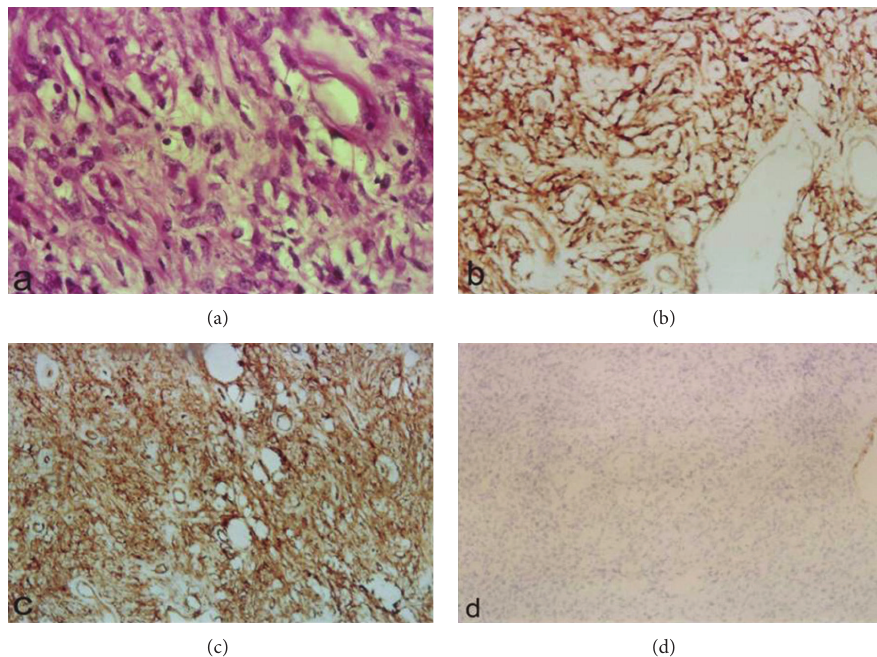
Figure 4: (a) Standard staining HE GX40: slight tumor proliferation with fusocellular cytonuclear atypies. Immunohistochemistry: CD99 antibody positivity (b), anti-CD34 (c), and Ki67 < 1% (d).